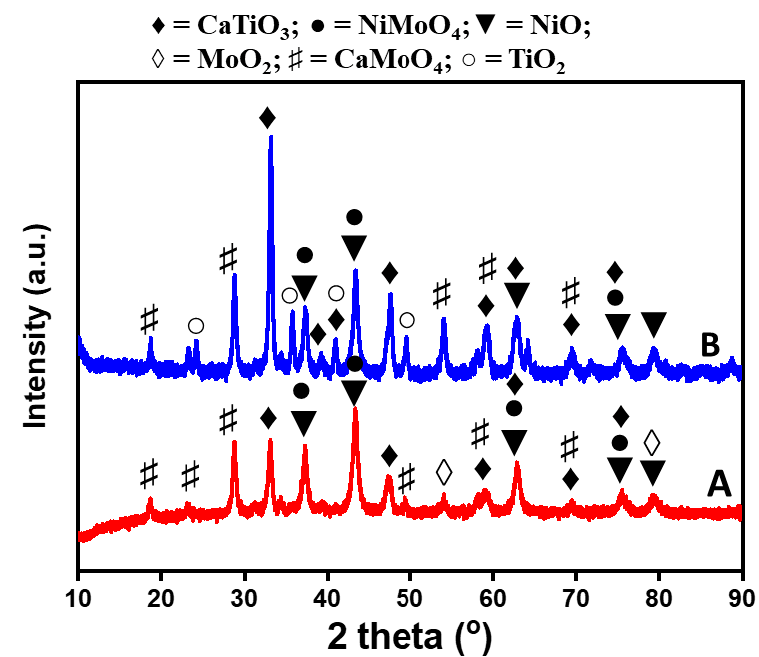
Figure 1. XRD pattern of NiMo/CaTiO 3 catalysts: (A) NMC412 and (B) NMC414.